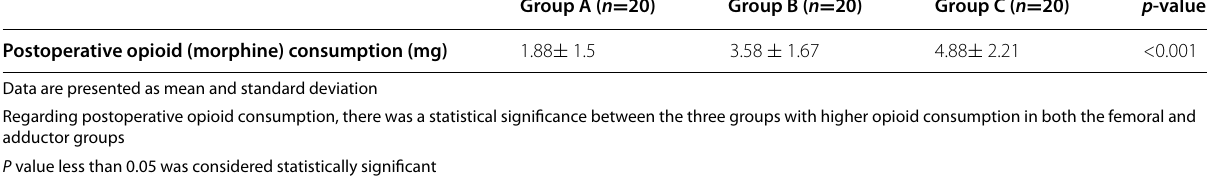
Table 4 Comparison between the three study groups as regard postoperative opioid consumption